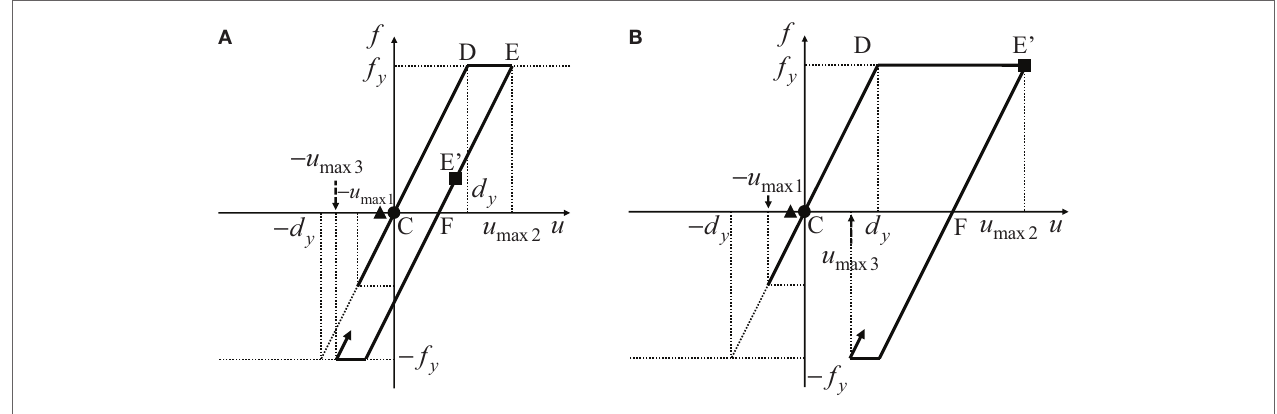
FigUre 3 | Two different cases in case 3: (a) case 3-1, (B) case 3-2 ( • : first impulse, ▴ : second impulse, ◼ : third impulse)